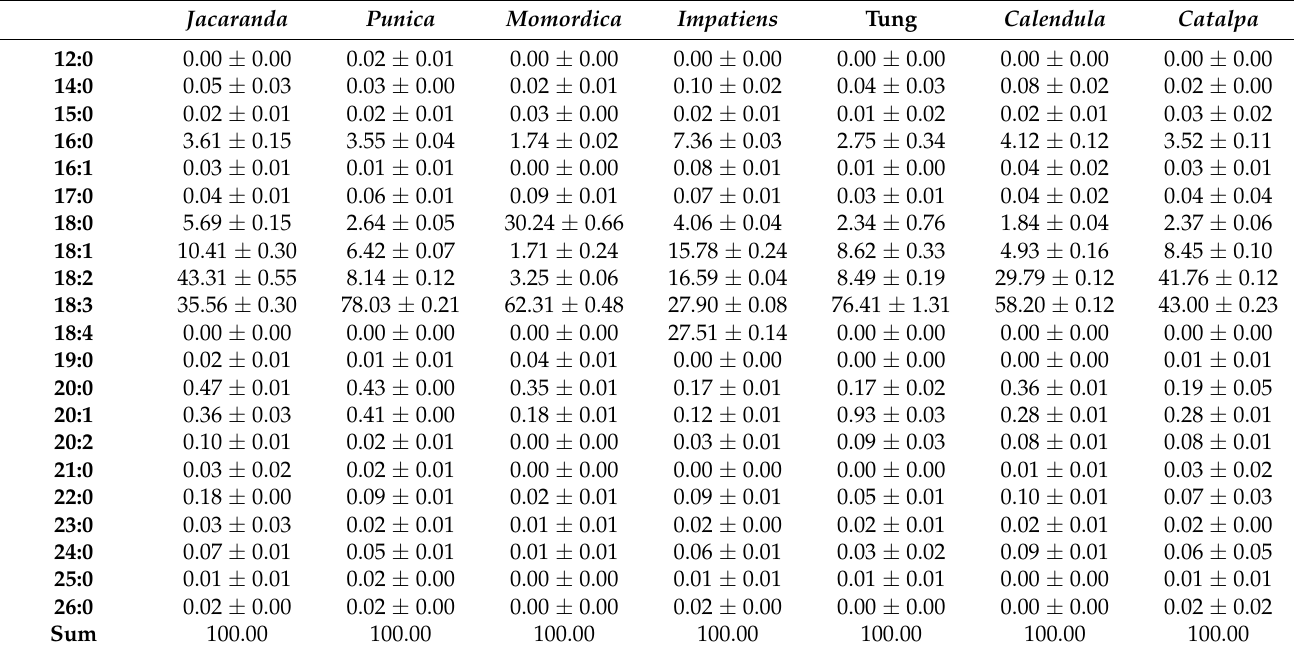
Table 2. Fatty acid percent relative compositions obtained by GC-FID for seven samples and arranged by carbon number of acid and degree of unsaturation. Relative abundances include isomer contributions and are averages from three independent analyses. Uncertainties are 95% confidence limits based on the t -distribution with 2 degrees of